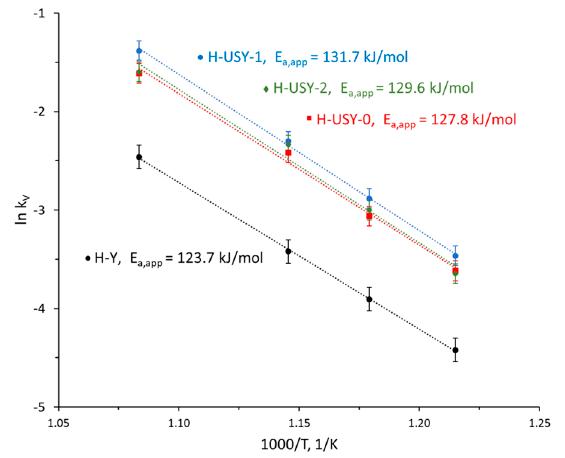
Figure 7. Arrhenius plot of the first-order rate constant, k V , for the catalytic cracking of n -hexane over H-Y and H-USY zeolites.